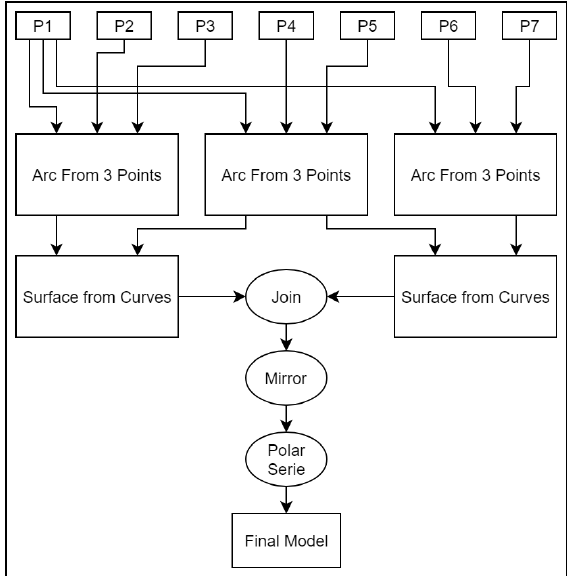
Figure 6. Diagram of the algorithmic modelling process of the stellar